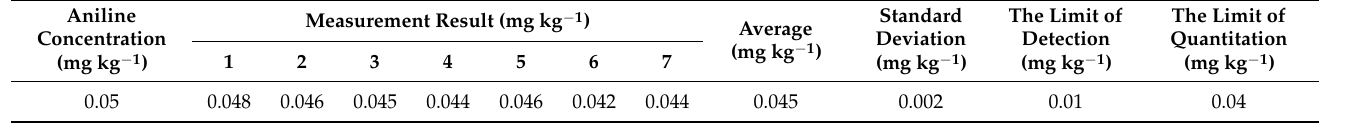
Table 2. Standard deviation, detection limit and lower limit of determination of the method.